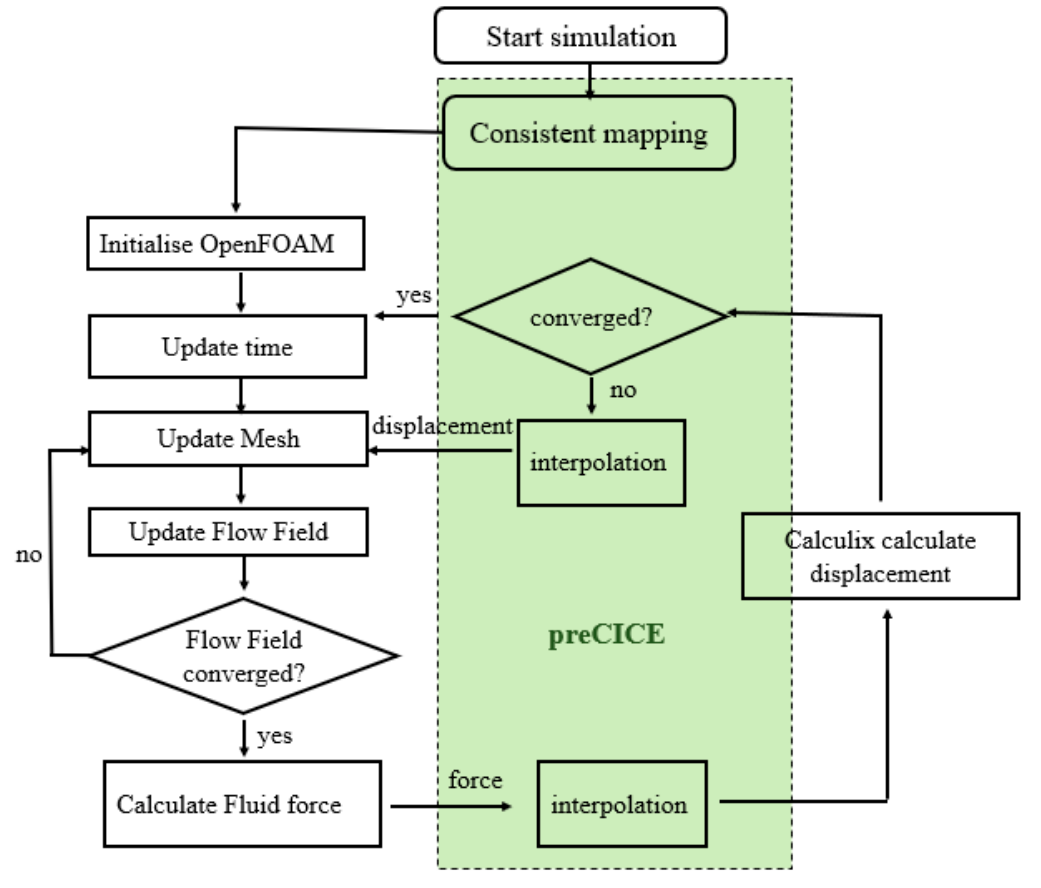
Figure 1. Model description.